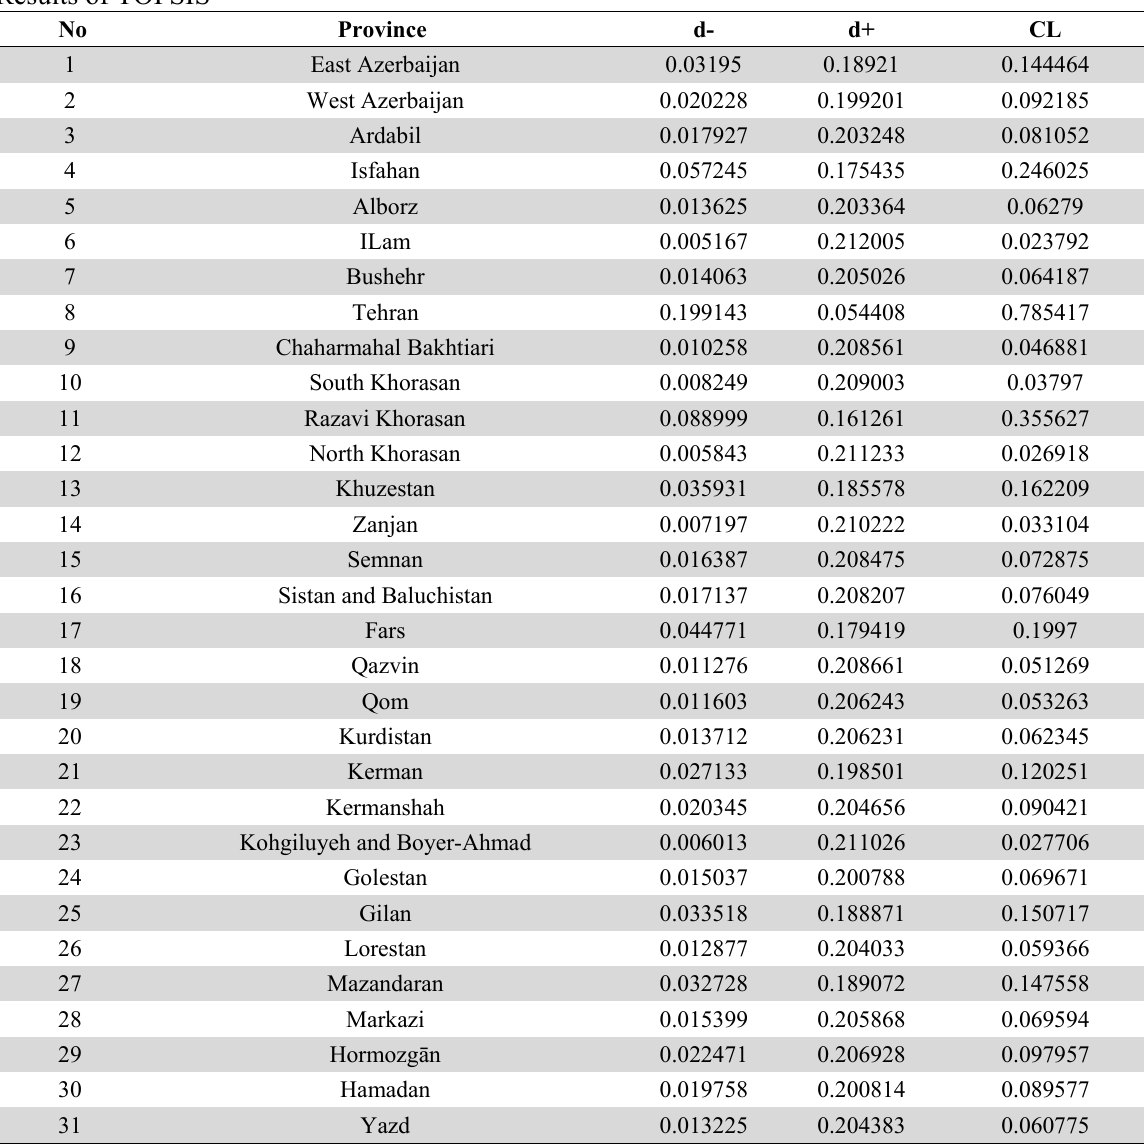
Table 4 Results of